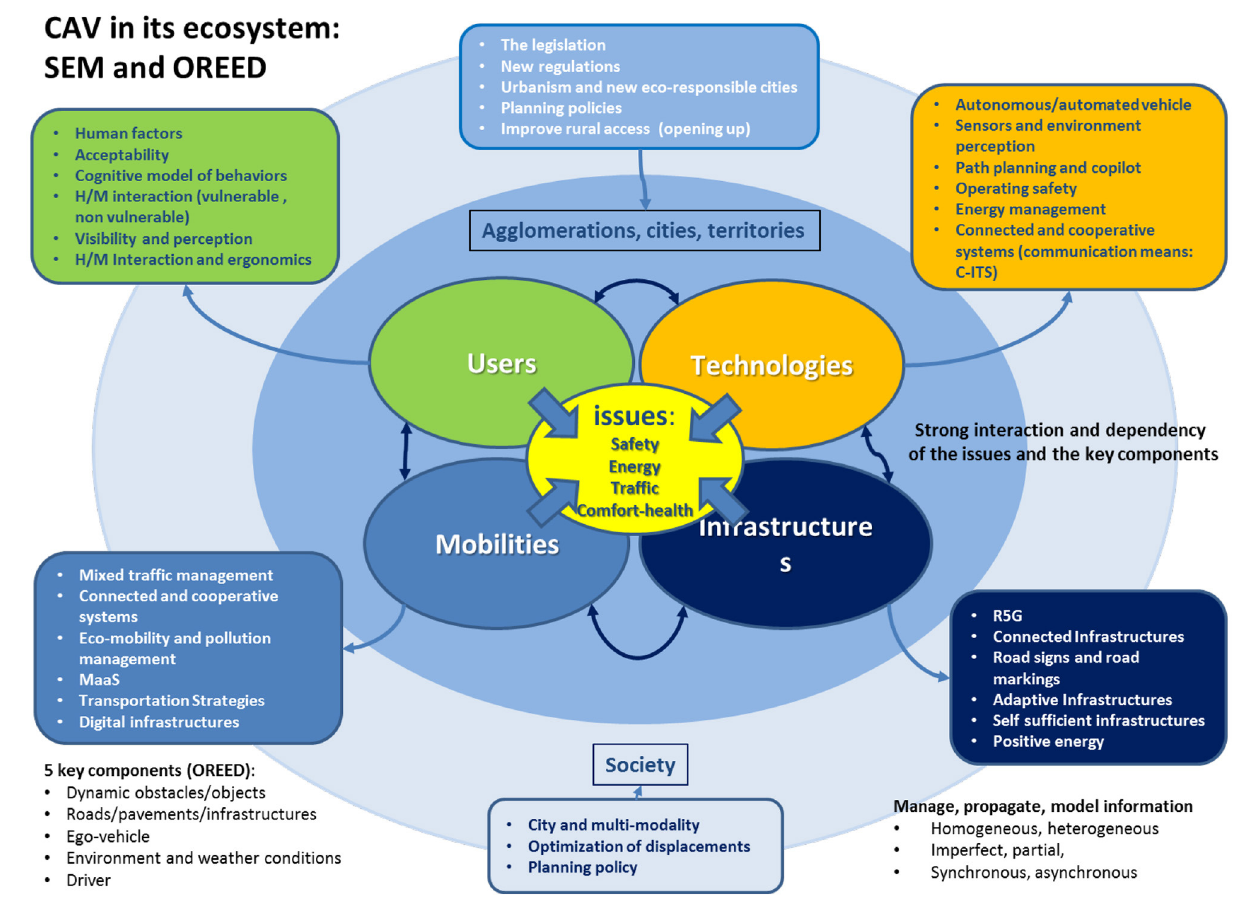
FIGURE 3 | A complex ecosystem with multiple levels and with strong interactions.